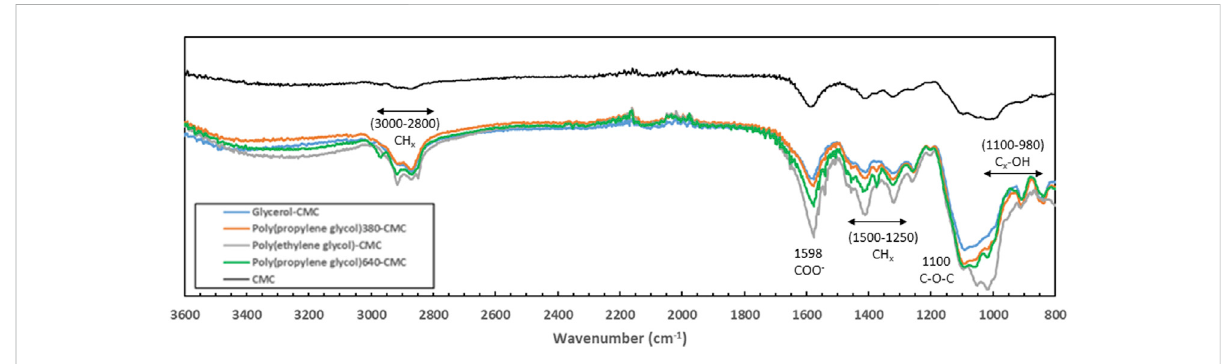
FIGURE 2 FTIR spectra for the family of diglycidyl ether crosslinked CMC fi lms.